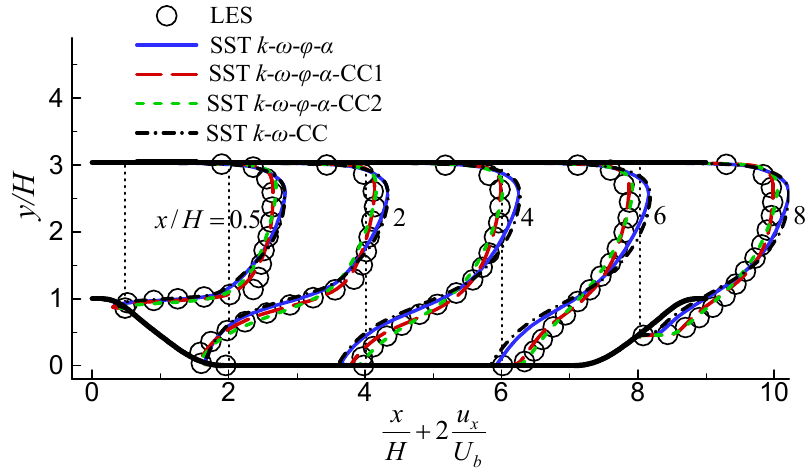
Figure 11. Velocity magnitude contours predicted by different turbulence models.